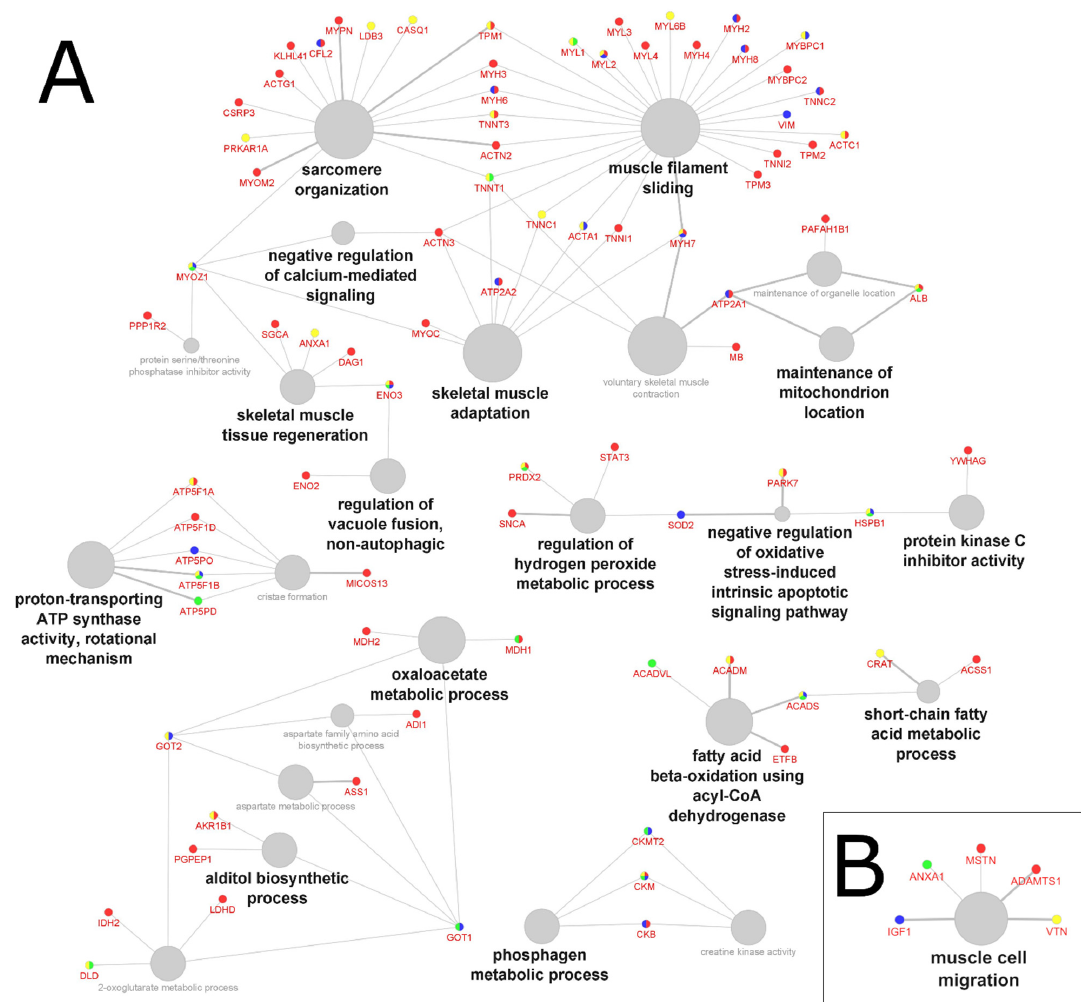
Figure 2. GO clustering based on logical “AND” for all four atrophy groups in ( A ) tissue samples and ( B ) biofluid samples from 24 proteomics studies. Grey nodes represent common (shared) up- and downregulated processes; the font and node sizes reflect statistical significance (kappa score = 0.4 and p -value < 0.01). The red, blue, green, and yellow colors associated with proteins arbitrarily represent the muscle atrophy